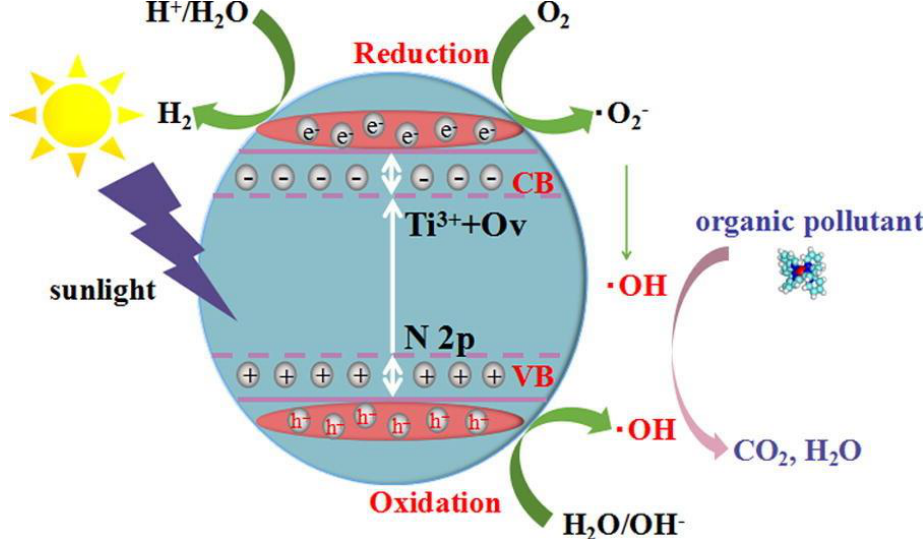
Figure 6. N-doped TiO 2 photocatalytic process driven under the sun is schematically represented [154].